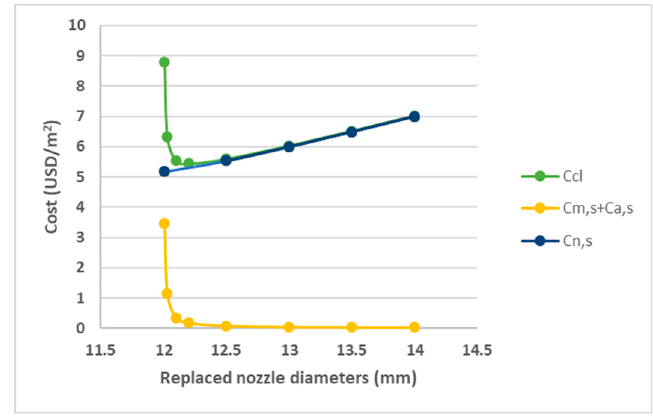
Figure 4. Relation between cleaning cost components and replaced nozzle diameter.